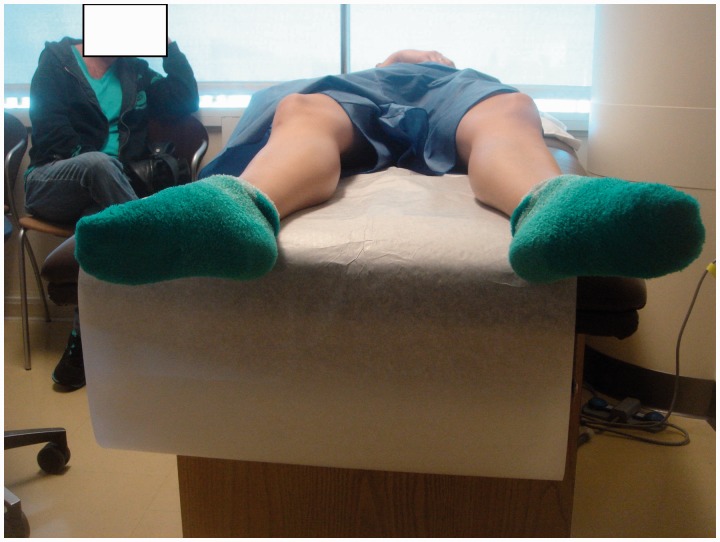
Log roll. As the patient is laying supine, the resting position of her right leg is significantly more externally rotated than her left leg, consistent with laxity of her ILFL. Generally, this test starts with the patient supine, and the examiner rotates the leg internally and then lets the leg passively fall into external rotation.